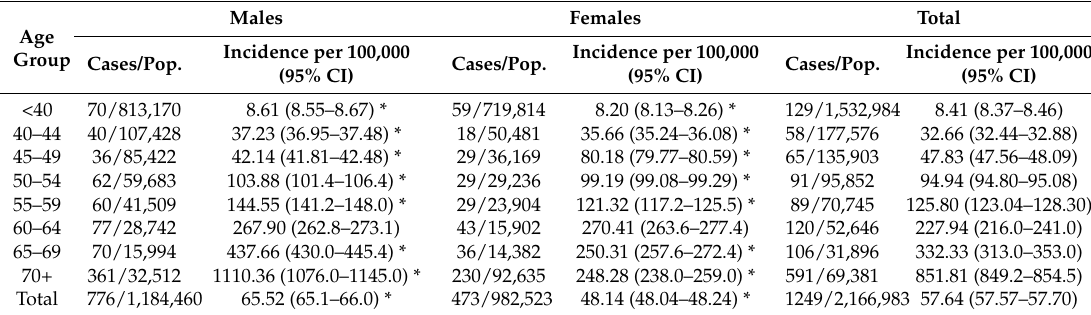
Table 1. Minimal incidence rate of hospitalized first-time stroke patients (per 100,000 people) and concomitant 95% Confidence Intervals (95% CI) by gender and age groups.